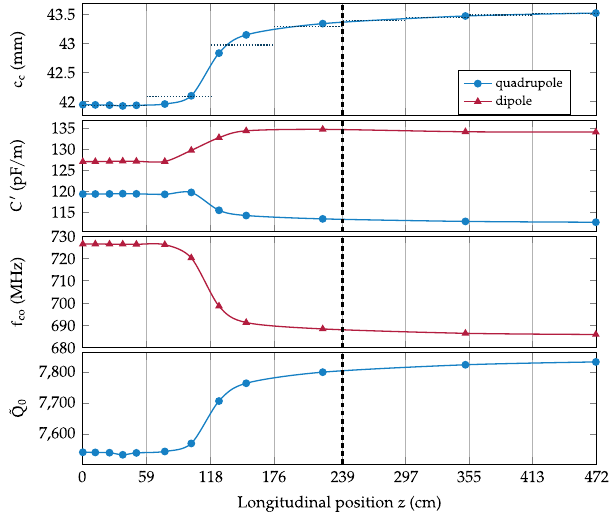
FIG. 25. Rfparameters alongthe RFQ derivedfromsimulationof individual cells. The vertical lines indicate the approximate dimen- sions of the 2 × 4 RFQ modules (intercavity drift is